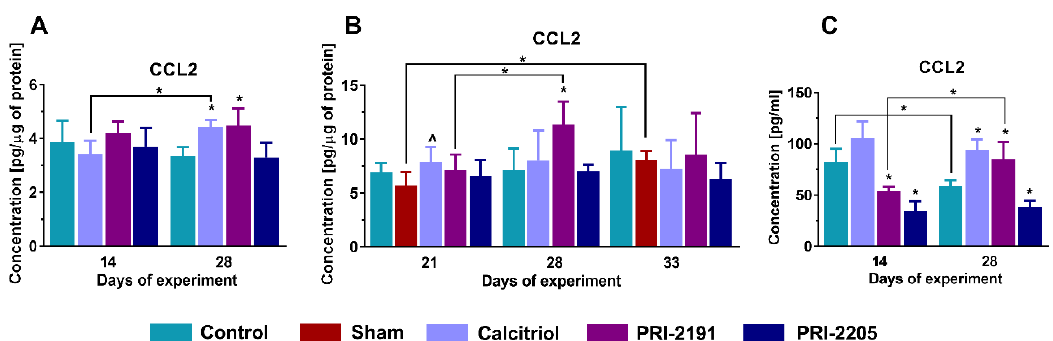
Figure 6. Changes related to CCL2 expression in 4T1 tumor-bearing young and aged OVX mice. Expression of CCL2 in ( A , B ) tumor tissue or ( C ) plasma of ( A , C ) young or ( B ) aged OVX mice measured using ELISA assays. The analysis was performed on samples harvested at days 14 and 28 (young mice) or days 21, 28, and 33 (aged OVX). Briefly, 60-week-old mice were subjected to ovariectomy or sham surgery. After 4 weeks, 4T1 cells were inoculated (day 0) orthotopically into aged OVX mice or 6–8-week-old young mice, and subcutaneous administration of tested compounds (three times a week) was initiated on day 7 at the following doses: calcitriol, 0.5 µg/kg; PRI-2191, 1.0 µg/kg; and PRI-2205, 10.0 µg/kg. The number of mice analyzed was 3–7 per group. Data presentation: ( A – C ), mean with standard deviation (SD). Statistical analysis: ( A – C ), Kruskal–Wallis multiple comparison test. * p < 0.05 as compared to control animals or ^ p < 0.05 as compared do control sham animals on the relevant day of treatment or as indicated. CCL2—chemokine (C-C motif) ligand 2.